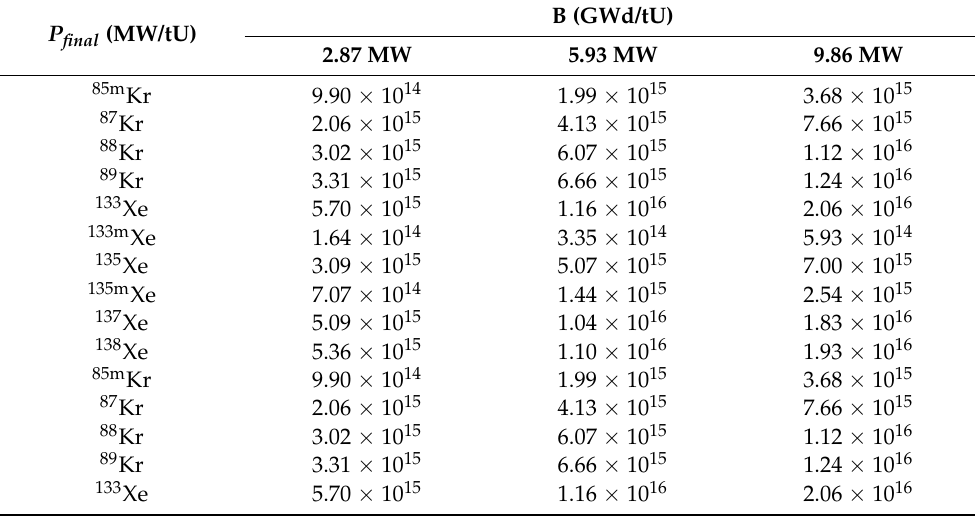
Table 7. Inventories of fission gas nuclides (Bq) for non-equilibrium